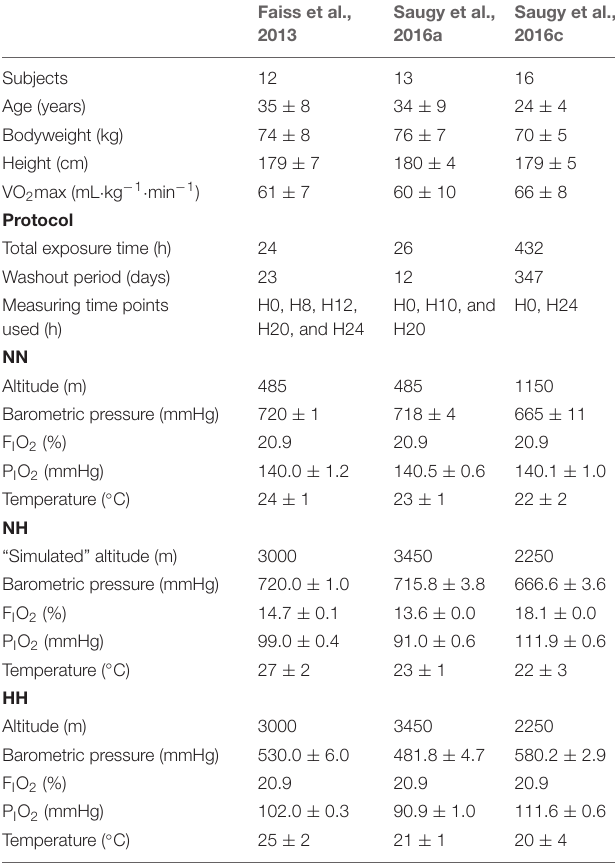
TABLE 1 | Data are reported as mean ± standard